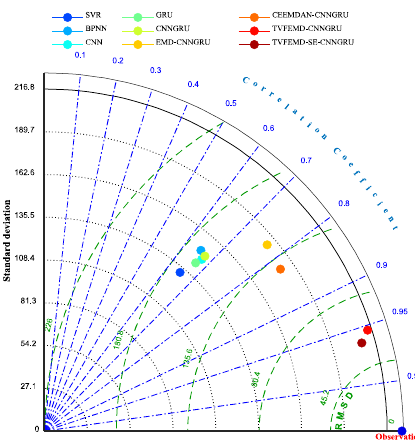
Figure 11. Histogram of metrics MAE and R 2 .